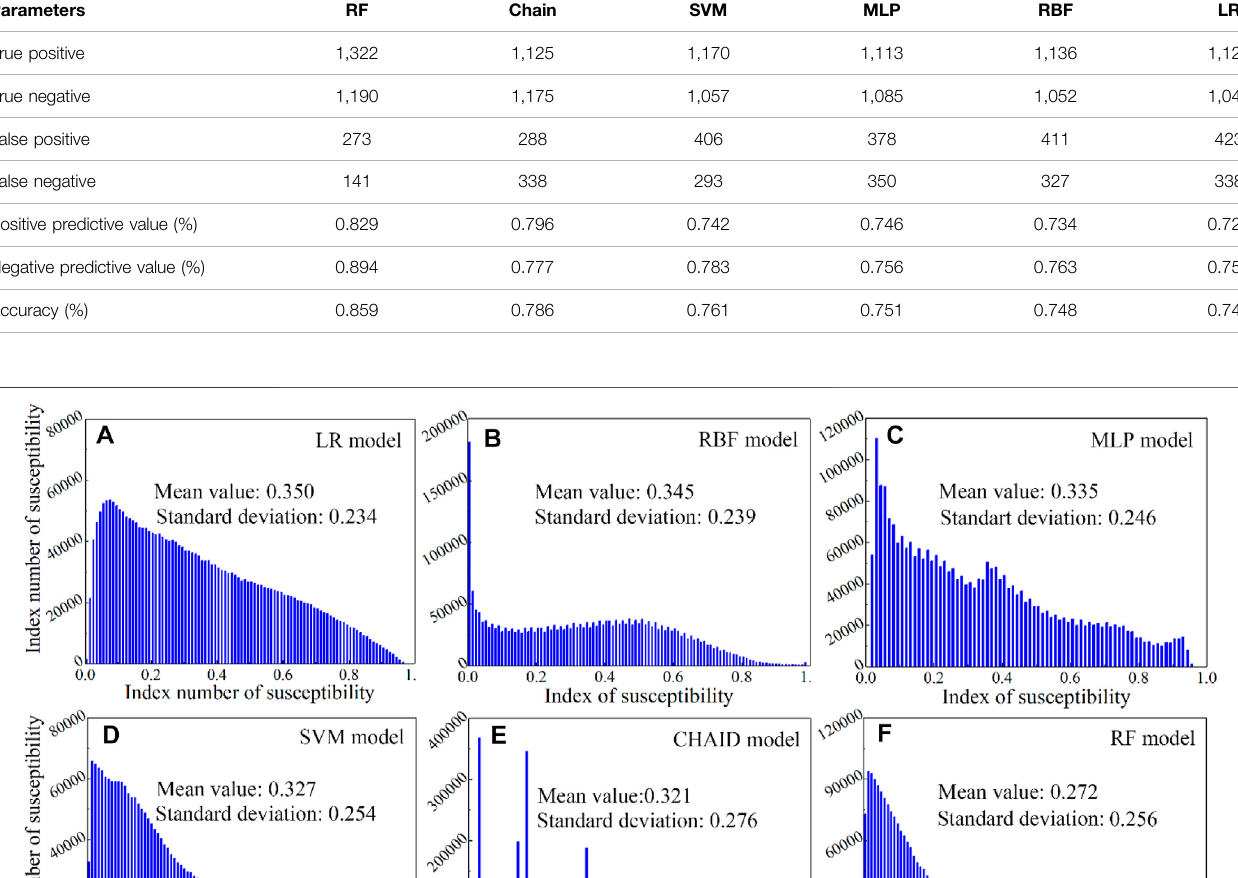
Frontiers in Earth Science |